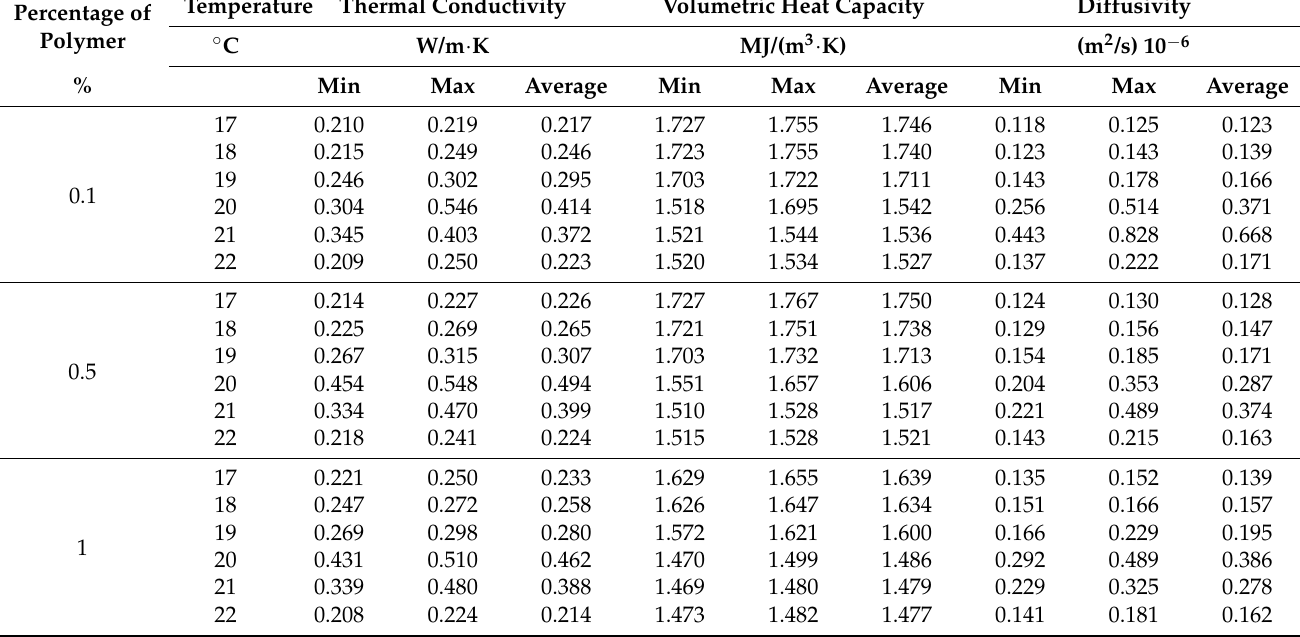
Table 5. Results obtained during measurements of gypsum thermal